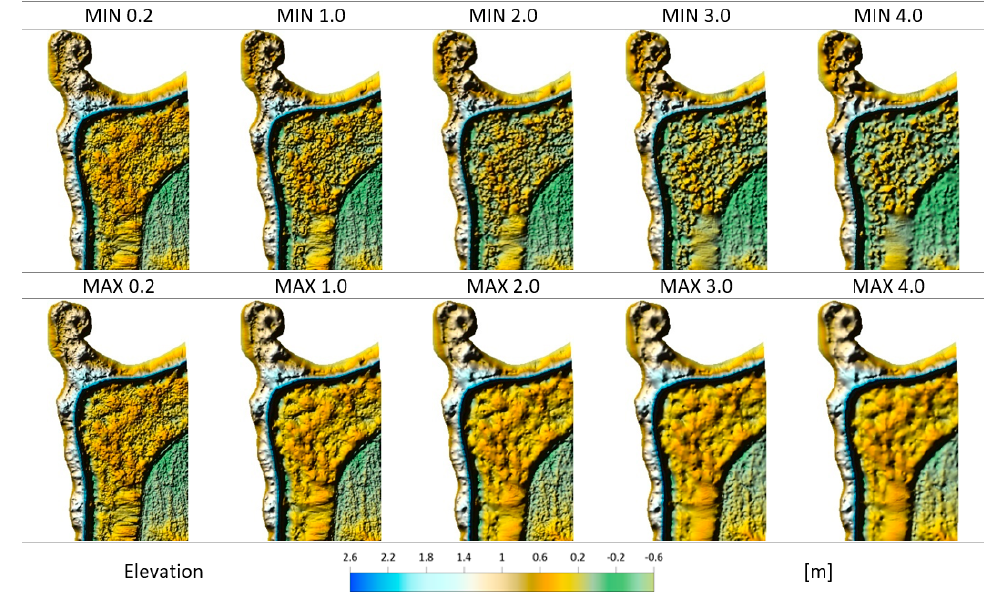
Figure 17. Comparison of DTMs under the kriging method.